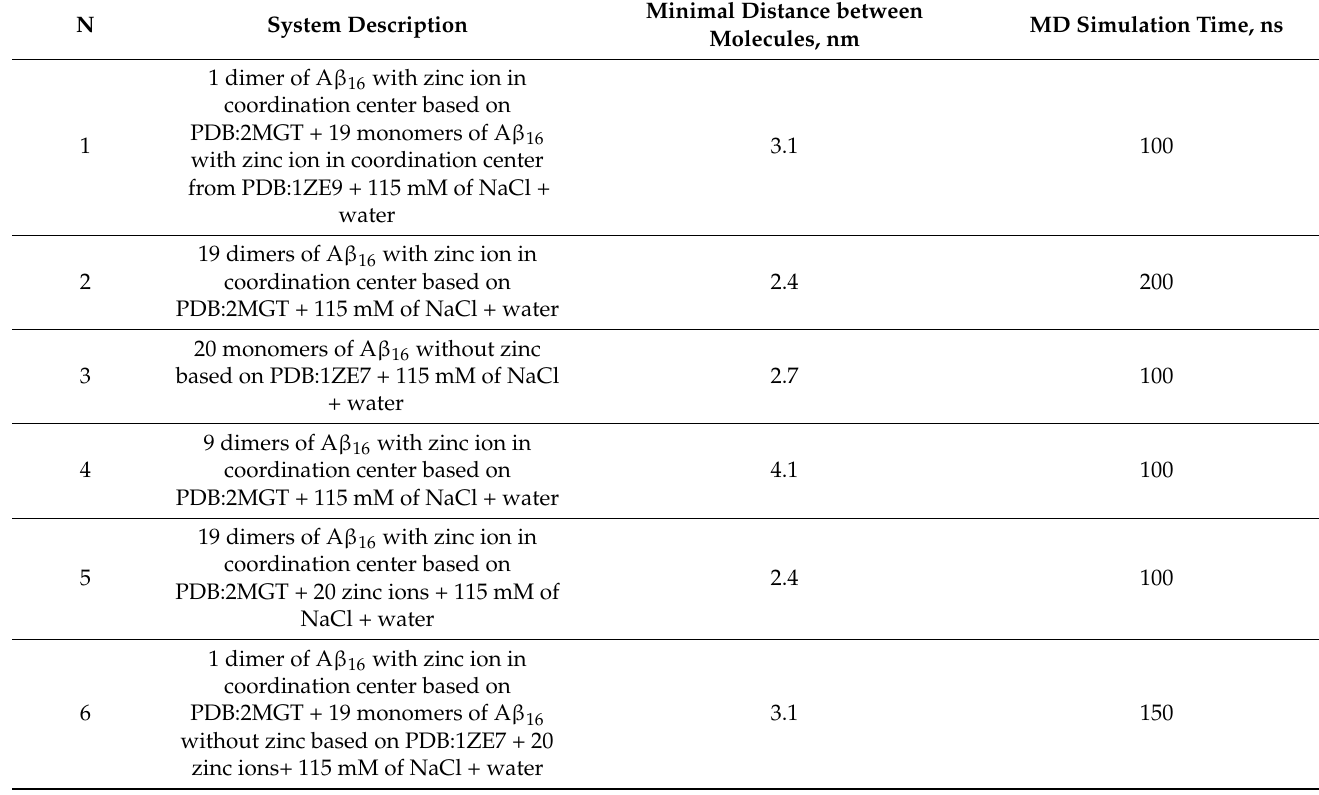
Table 1. Description and MD simulation parameters for all systems modeled in this study, with various A β 16 initial structures and zinc